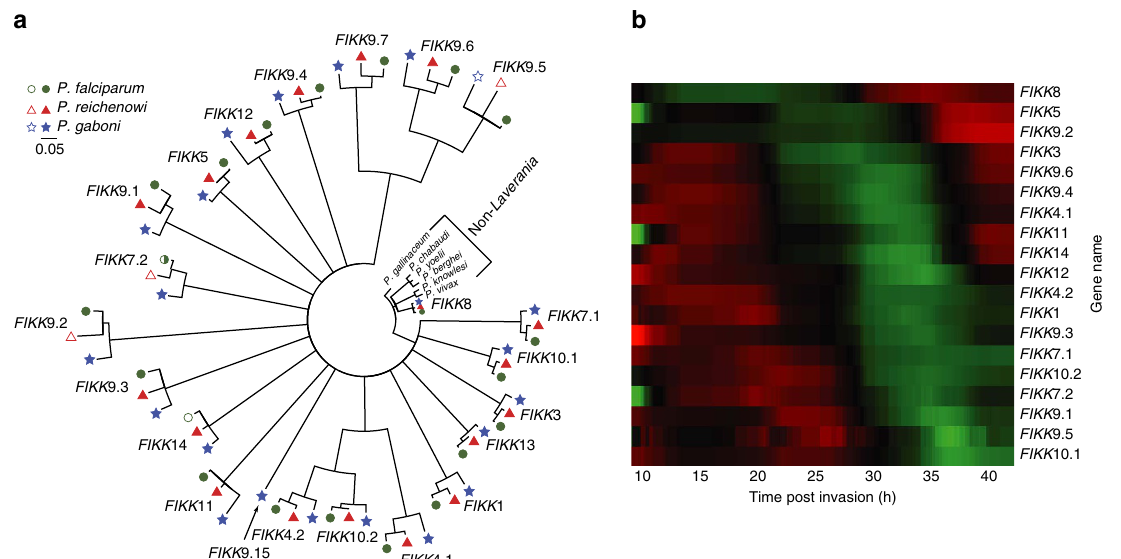
Figure 3 | Expansion and diversification of the FIKK multigene family in the Laverania subgenus. ( a ) Phylogeny of FIKK genes from P. falciparum (green), P. reichenowi (red), P. gaboni (blue) and non- Laverania species (black). FIKK genes are labelled according to their P. falciparum orthologues, with the new P. gaboni gene designated FIKK 9.15. Open symbols indicate pseudogenes in all members of the species ( FIKK 7.2 is intact in some strains of P. falciparum ). The tree was inferred using maximum likelihood methods 69 using an alignment of first and second codon positions. Internal branches with bootstrap support of o 70% are collapsed. Scale bar, 0.05 substitutions per site. ( b ) Expression profiles of P. falciparum FIKK genes. Previously published microarray data 23 from 21 clonal P. falciparum strains were used to calculate the expression levels of 19 FIKK genes at different time points during the intra-erythrocytic lifecycle (data for the remaining FIKK gene were not available). Colours represent mRNA expression levels relative to a reference pool, with red, black and green indicating higher, equal and lower expression levels than the reference pool, respectively. Genes were arranged to illustrate the sequential nature of FIKK gene expression.